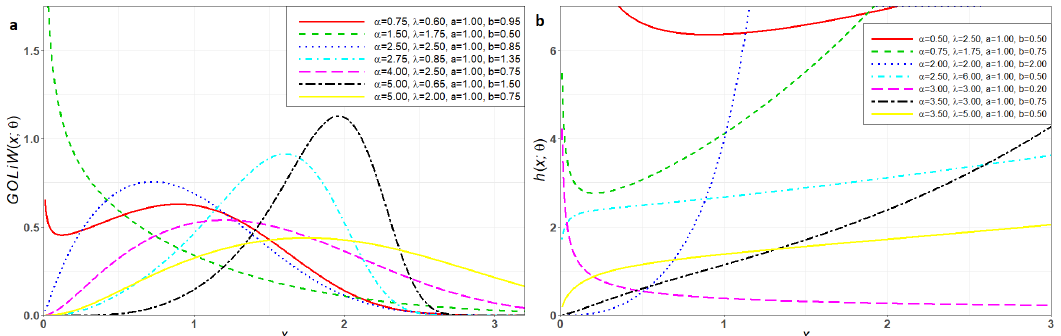
Figure 1 - Plots of the GOLiW pdf ( a ) and hrf ( b ) for some parameter values.